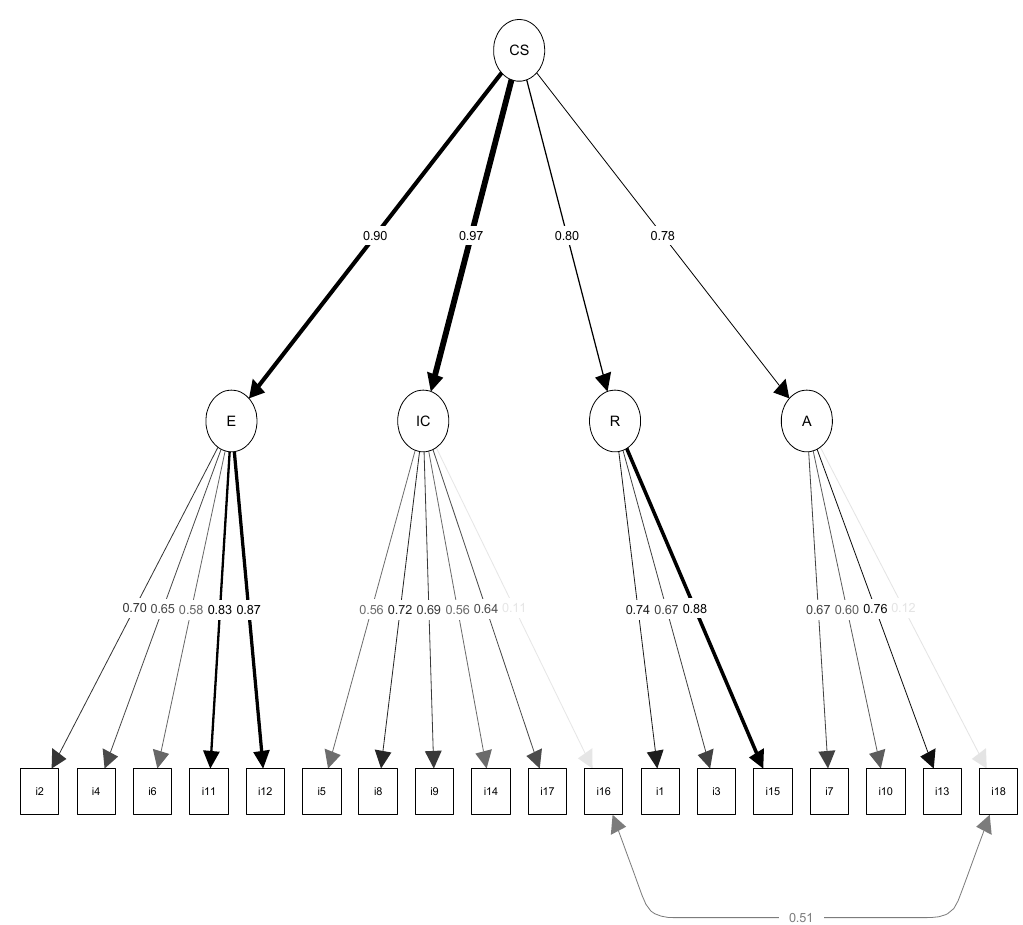
Figure 1. Confirmatory factor analysis of the original structure proposed by Leal et al. [22] graph extracted via the Lavaan package in the R freeware; CS = Health Professionals Communication Skills Scale E = Empathy; IC = Informative Communication; R = Respect; A = Social Skills or Assertiveness. Table 2. Confirmatory analysis and internal reliability consistency ( n = 289).